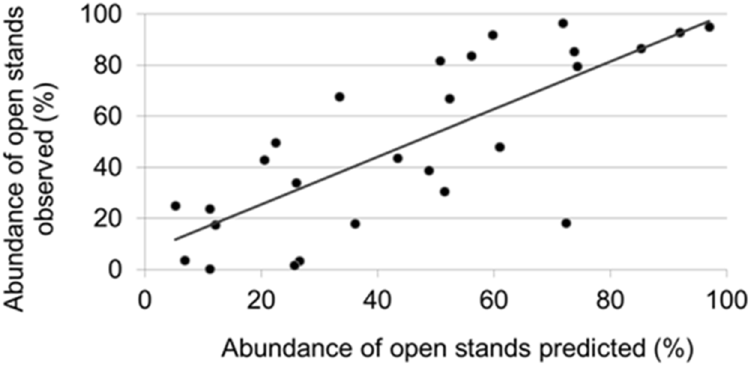
Figure 6. Predicted vs. observed abundance of open stands by fire zone. Predicted values stem from the logistic regression presented in Table 2.